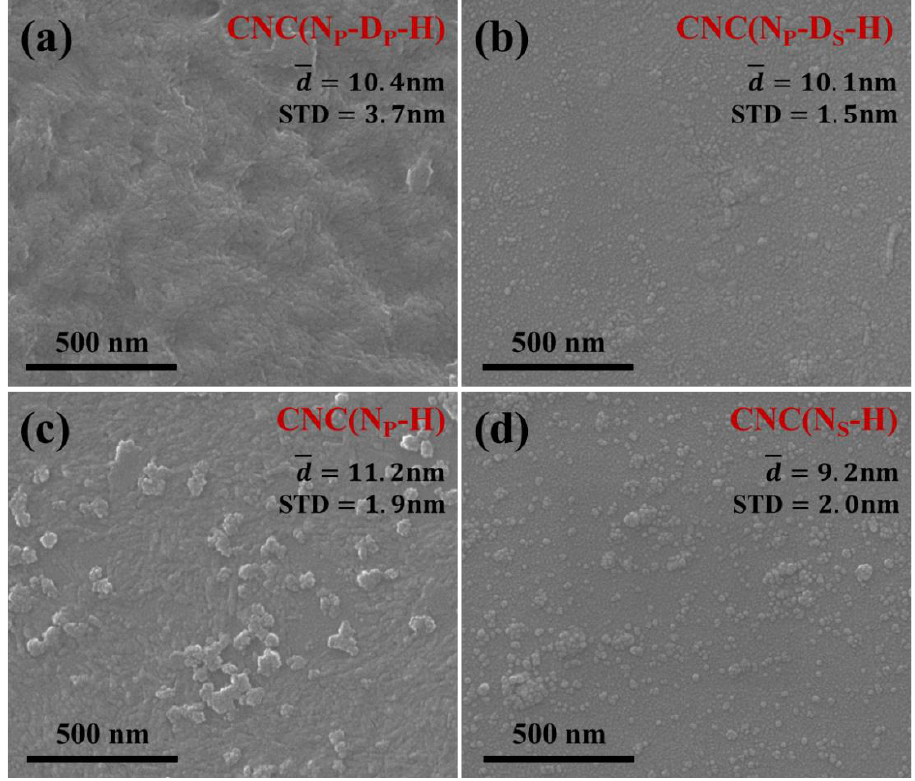
Figure 4. FE-SEM images of CNC samples prepared through different pretreatment routes (200,000× magnification).